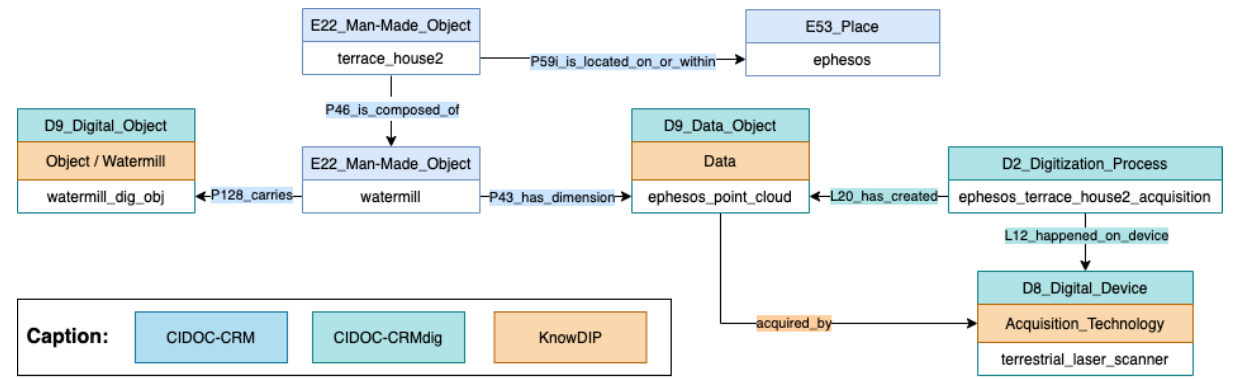
Figure 5. RDF representation of the watermills acquisition in Ephesos terrace house